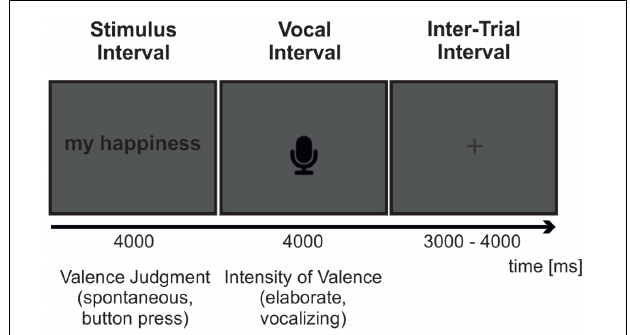
FIGURE 1 | Trial Sequence. Each trial consisted of a 4000 ms stimulus interval followed by a 4000 ms vocal response interval and an inter-trial interval uniformly distributed between 3000 and 4000 ms. Subjects had to coarsely judge the pronoun-noun phrases in reference to their feelings using one of three keyboard buttons (spontaneous valence judgments). The button press had to occur during the 4000 ms time window of stimulus presentation. As soon as the microphone icon appeared, subjects had to elaborate the intensity of the evoked feelings by speaking out the numbers ‘one’ to ‘nine’ corresponding to the nine-point self assessment manikin scale of emotional valence (elaborate valence